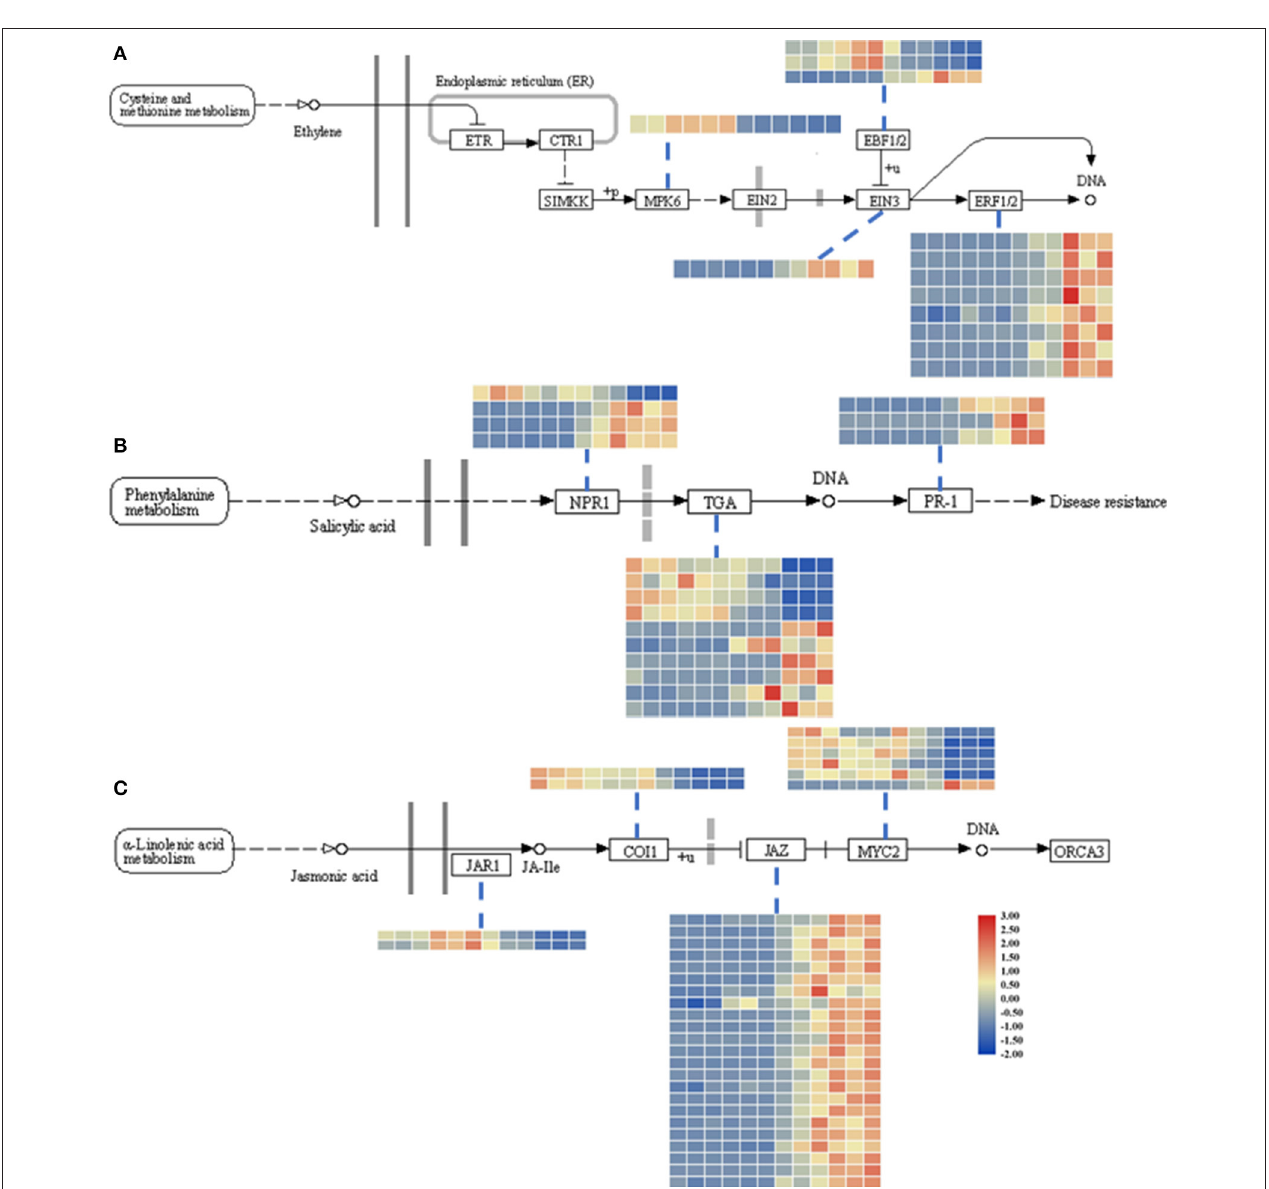
FIGURE 3 | Heatmap of DEGs related to the ET (ethylene; A ), SA (salicylic acid; B ), and JA (jasmonic acid; C ) signaling pathways. The descriptions of DEGs in this picture were listed in Table 1 . The heatmap was drawn with TBtools (Chen et al., 2020).